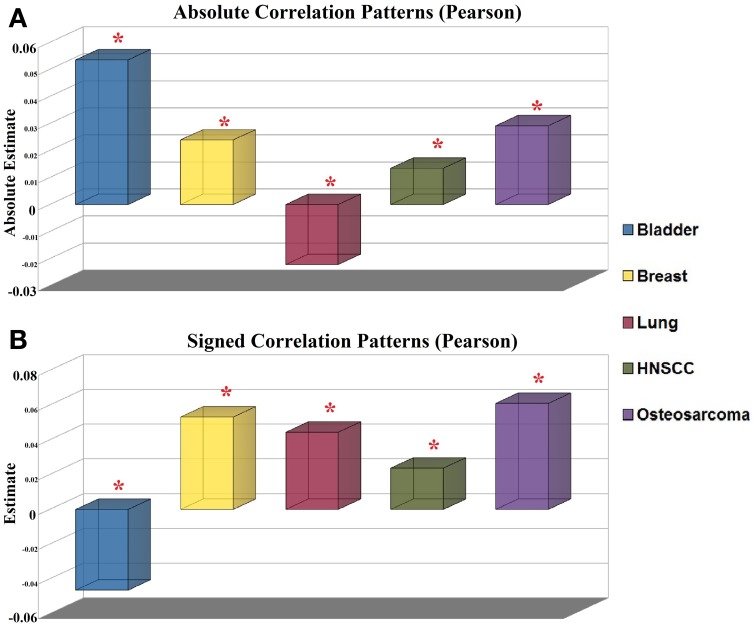
Pearson's correlation between DNA methylation and gene expression in five different types of cancer-normal tissues. (A) Reported estimates are the mean of the 95% CI obtained after calculating signed Spearman's correlations in 1000 random subsets of the same population size. Asterisks indicate significant differences at a 10% FDR. (B) Same as above for signed Pearson's correlation values.